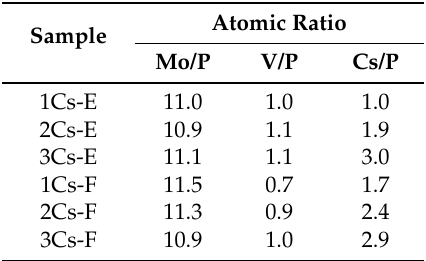
Table 1. Elemental analysis of the samples.